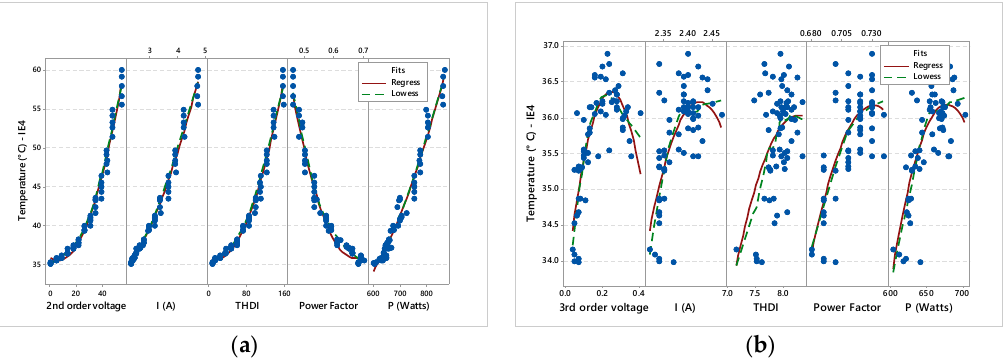
Figure 17. Temperature regression versus motor input parameters for IE4 class LSPMM with voltage distortion of ( a ) 2nd harmonic voltage distortion; ( b ) 3rd harmonic voltage distortion.